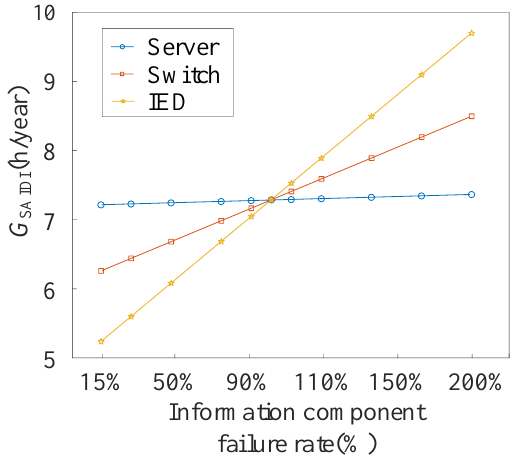
Figure 14. Trend of G SAIDI under different fault rates.